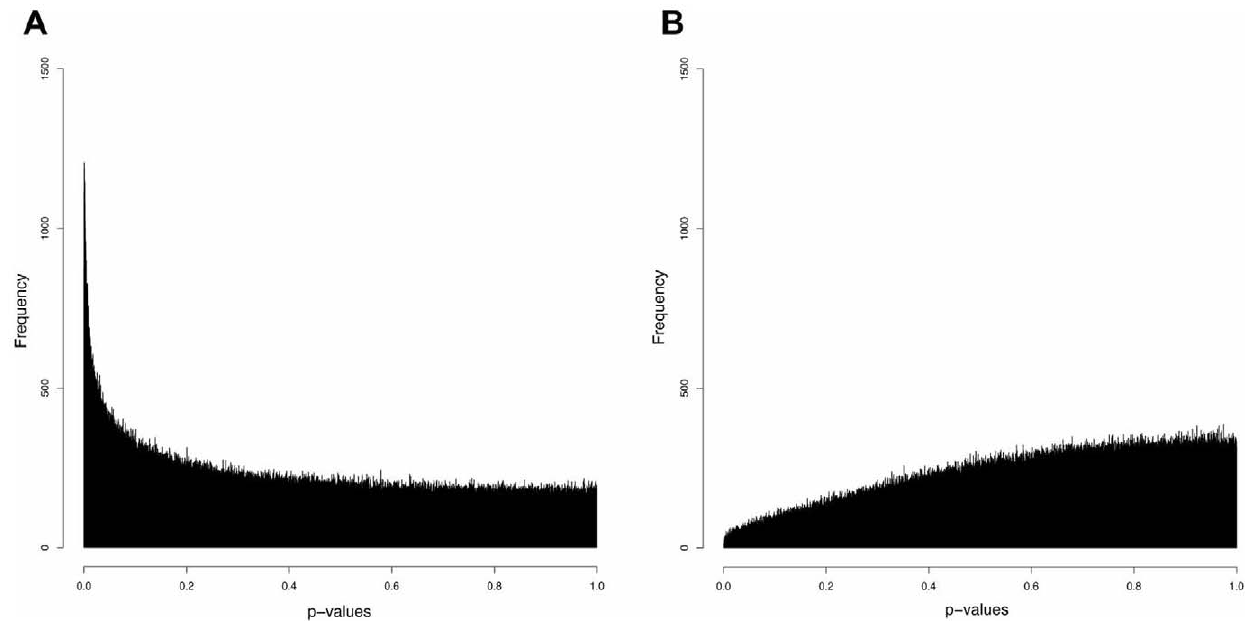
Figure 1. Supervised group comparisons reveal significant differences in HELP data results between IUGR and controls. Panel (A) shows a histogram distribution of p-values calculated from an unpaired T test of IUGR (n=5) in one group and controls (n=5) in another. The x axis represents p values, with lower values being the more significant, while the y axis shows the frequency of occurrence of different p values. The peak observed represents a subset of loci with low p values and thus significant differences between IUGR and control subjects. For comparison, panel (B) shows the results of a random distribution of subjects into two groups, mixing IUGR and controls, demonstrating the absence of a subset of loci with significant p values.